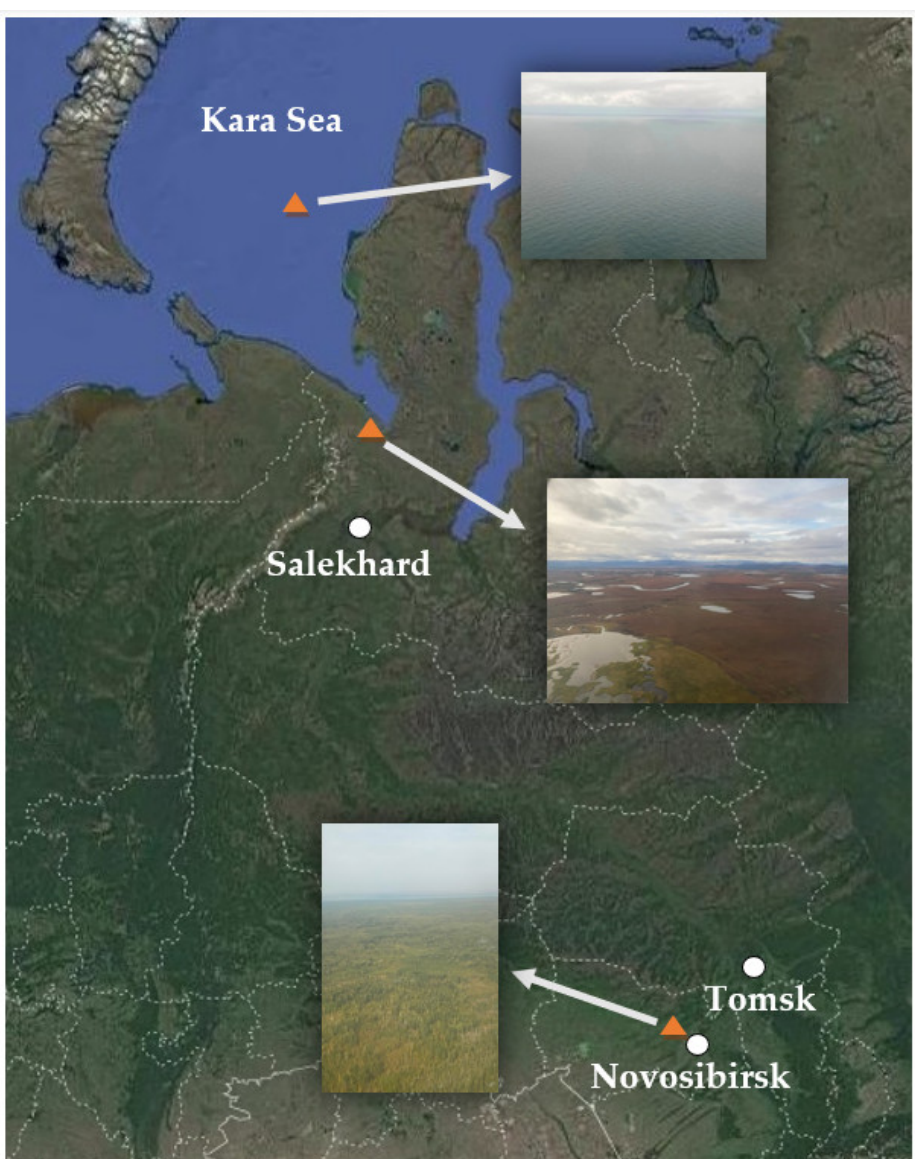
Figure 16. A map of methane measurements using an onboard lidar during a flight expedition (three points (orange triangles) were selectively taken from the array of experimental data obtained: Novosibirsk—midlatitude summer, Salekhard, in particular, locations of the coastal part and water area of the Kara Sea—Arctic summer).